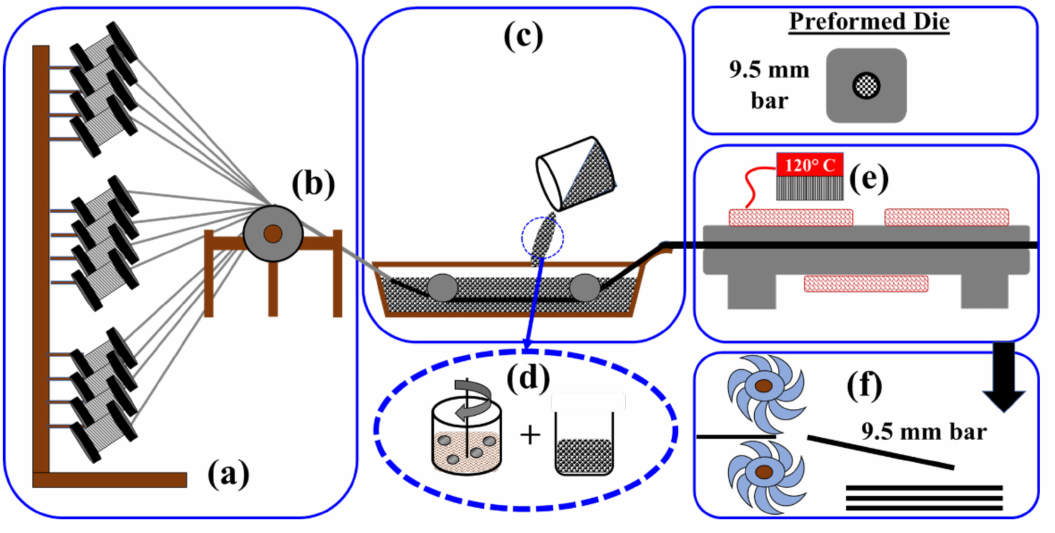
Figure 1. Schematic describing the pultrusion process: ( a ) fiberglass roving provision; ( b ) preforming; ( c ) open bath impregnation with nanomodified resin; ( d ) nanomodified resin synthesis; ( e ) curing die with heating plates; ( f ) take-o ff